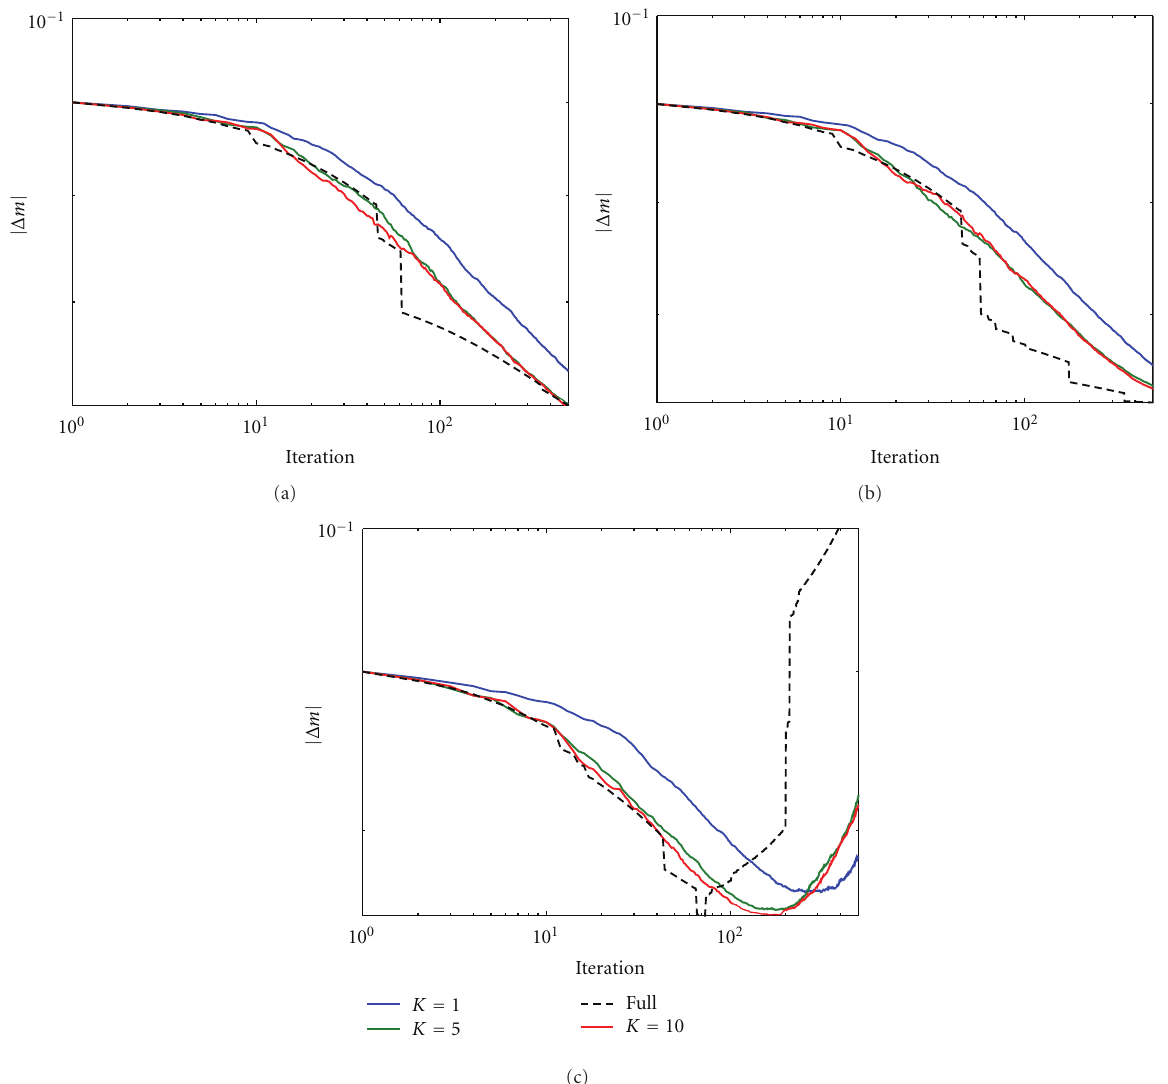
Figure 12: Error between the inverted and true model for the SA approach with limited averaging for various batch sizes and the full problem, (a) without noise, (b) with noise (SNR = 20 dB), and (c) with noise (SNR = 10dB). The convergence is smoother than that of SA without averaging, especially when the data is very noisy (10dB). The averaging seems to slow down the convergence slightly, however, and we need a batch size K = 5 for the best